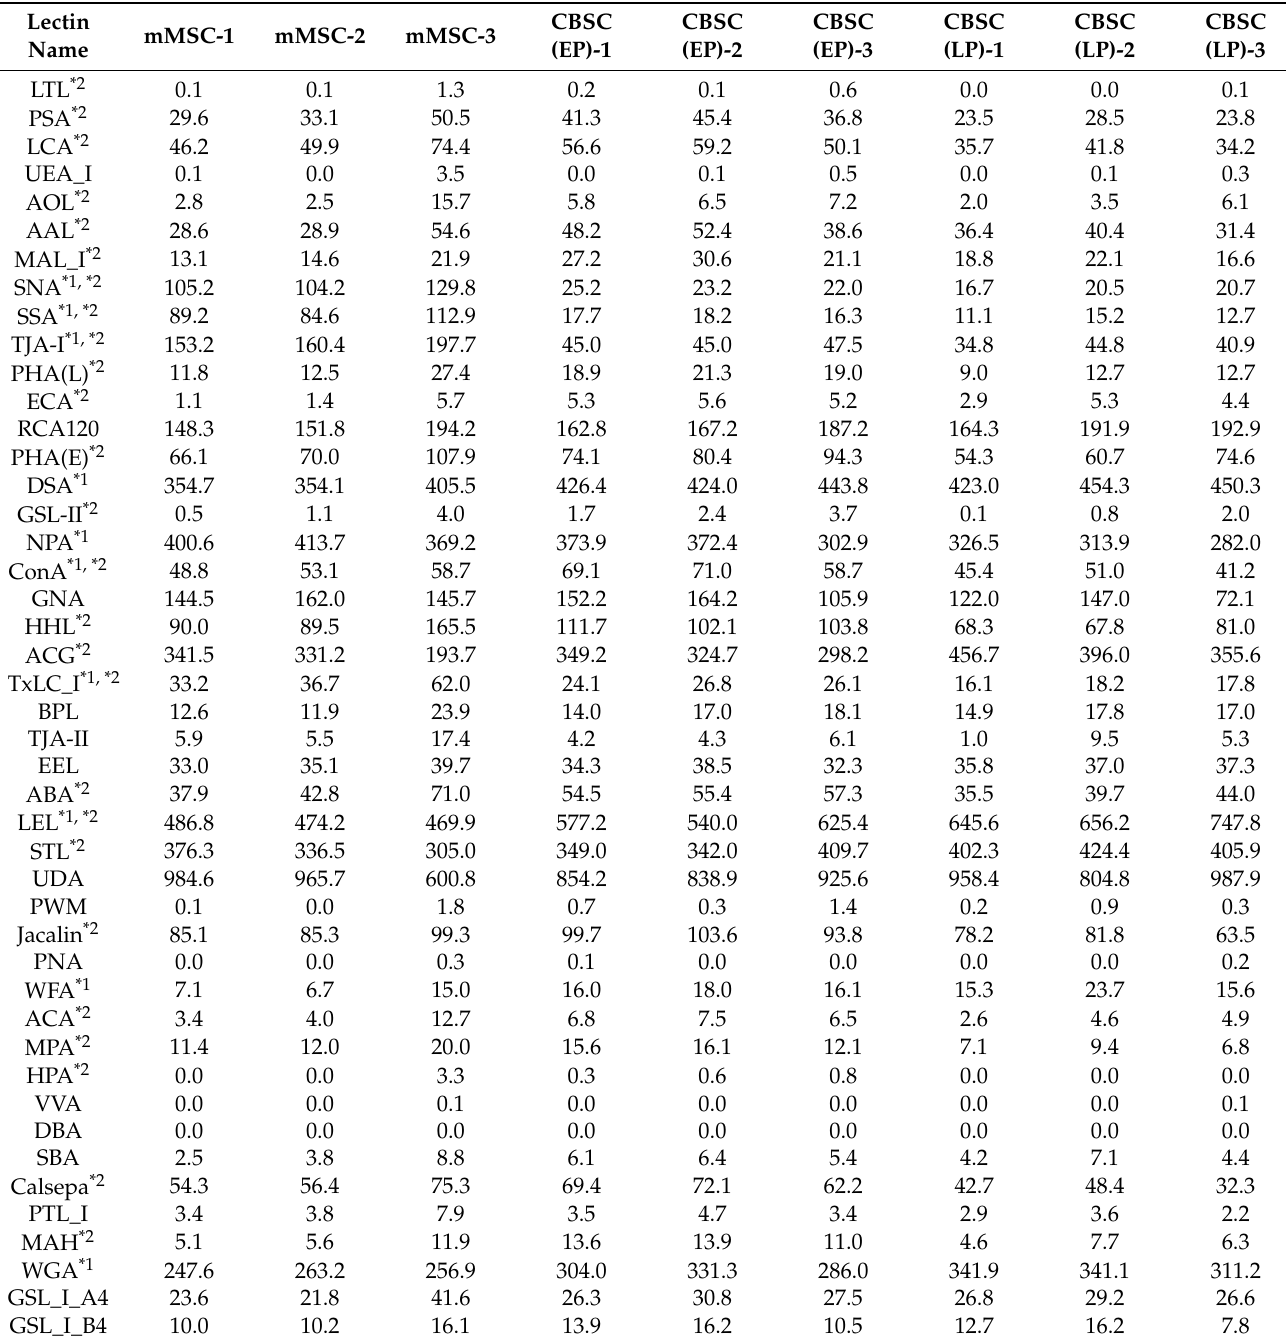
Table 1. The signal intensities of each cell type in lectin microarray